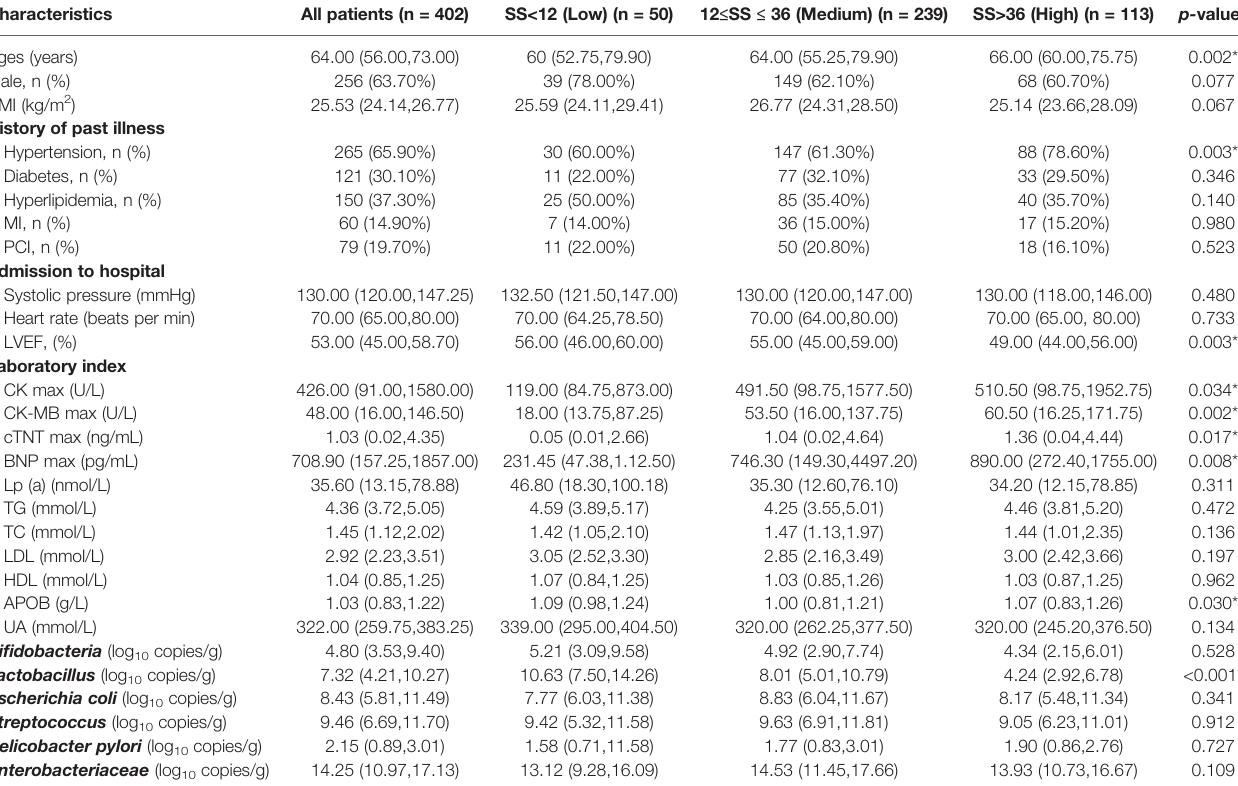
TABLE 2 | Demographic, biochemical characteristics, and bacterial quanti fi cation of patients grouped according to the SYNTAX score.